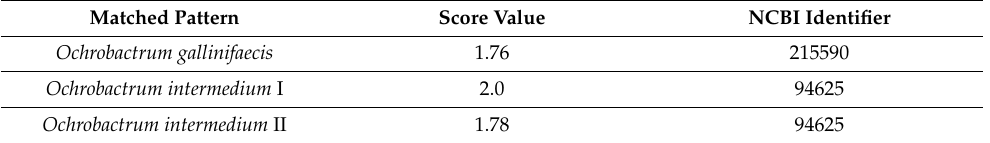
Table 1. Pathogens identified using the MALDI-TOF MS, including score value and NCBI identifier.